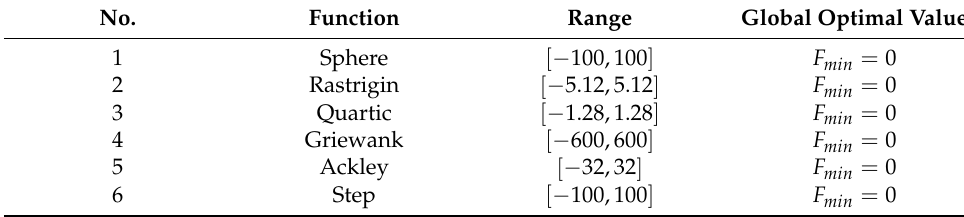
Table 2. The test function used in the experiment and some